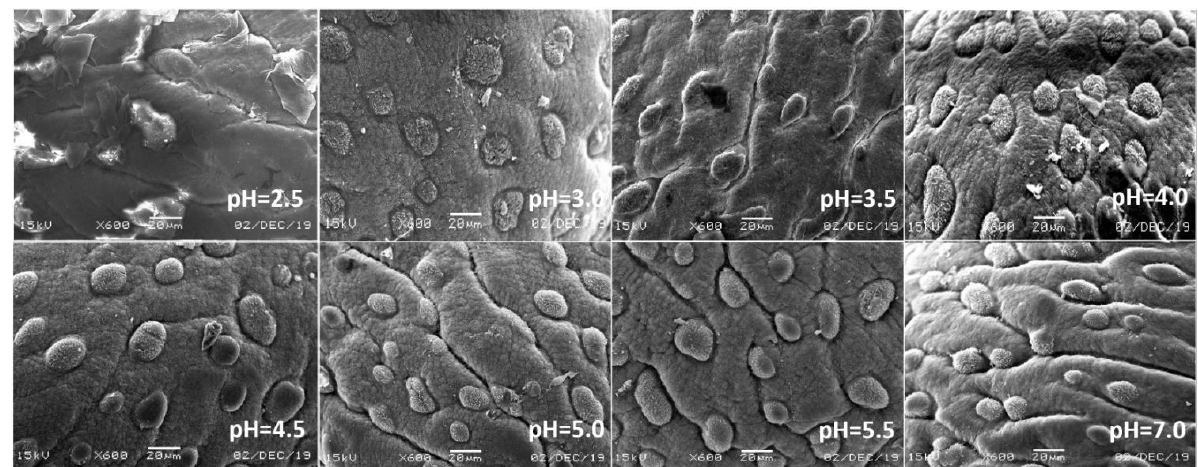
Figure 6. Epidermis of the first segment of adult Eisenia fetida on filter paper under acid rain with eight pH levels for 72 h ( n = 10). Treatments: pH 7.0: control, pH 2.0–5.5: acid rain with different pH levels.